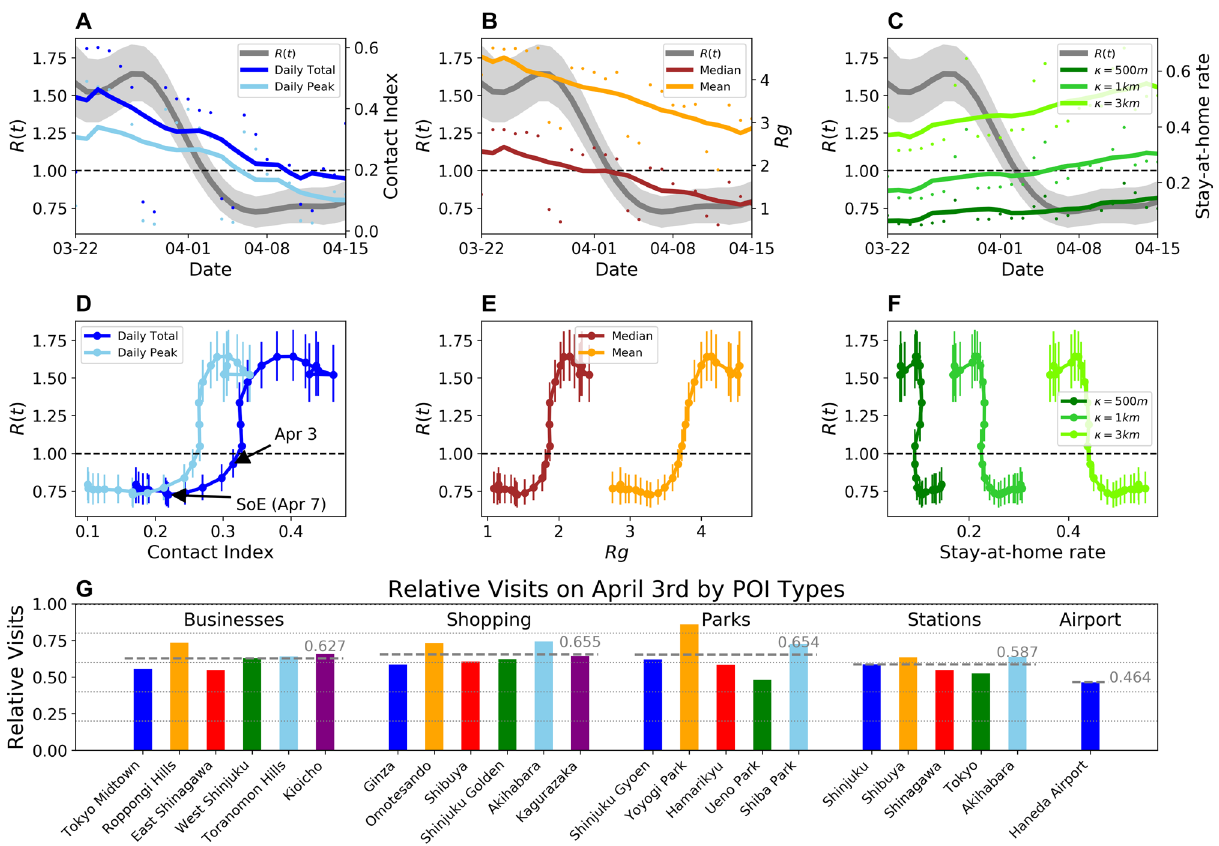
Figure 4. Correlation between mobility behavior changes and effective reproduction number R ( t ). ( A – C ) shows the human mobility metrics along with the R ( t ) values in Japan estimated by the health ministry panel on coronavirus infection cluster under the Japanese Government. ( D – F ) shows the relationships between the mobility metrics and R ( t ). All panels show that R ( t ) falls under 1.0 with reduction in mobility and social contacts, and that such reduction may have been excessive in containing the spread of COVID-19. ( G ) Relative amount of visits to various point of interests on April 3rd, when sufficient reduction in transmissibility was achieved in